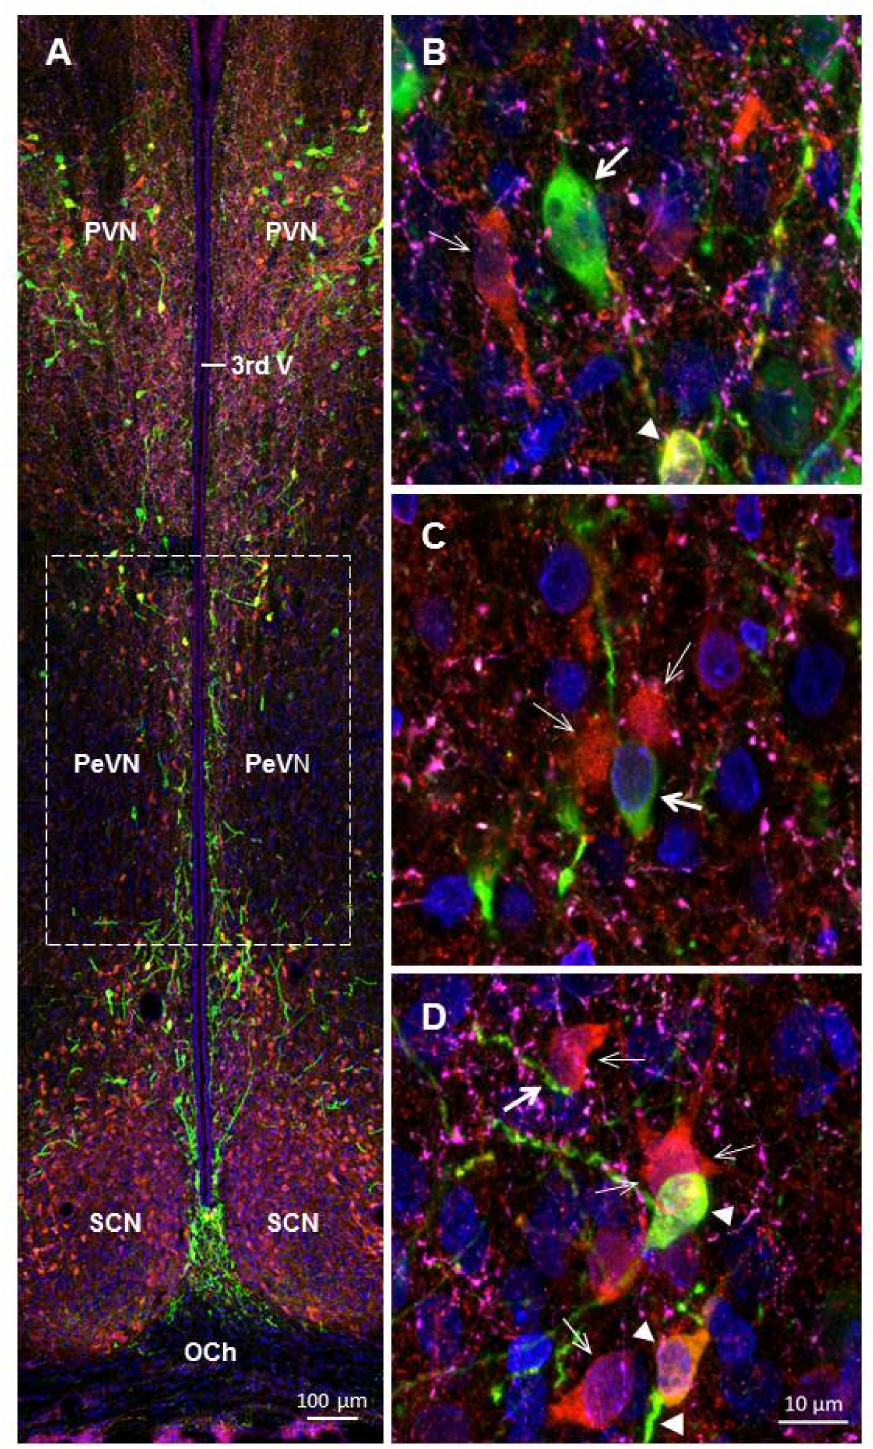
Figure 3. Confocal microscopy of the periventricular nucleus (PeVN) of the rat on frontal sections of the brain ( A – D ). ( A ) general view of the PeVN (dotted frame); ( B , C ) neurons, immunopositive for tyrosine hydroxylase (TH), but immunonegative for aromatic L-amino acid decarboxylase (AADC) (green, thick arrow); ( B – D ) neurons immunopositive for AADC, but immunonegative for TH (red, thin arrow); ( B , D ) neurons, immunopositive for TH and AADC (yellow, arrowhead). Scale: A 100 µ m, B-D 10 µ m. OCh, optical chiasma; PVN, paraventricular nucleus; SCN, suprachiasmatic nucleus; 3rd V, third